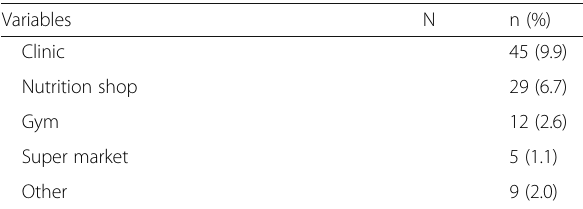
Table 2 Use of health supplements among participants in